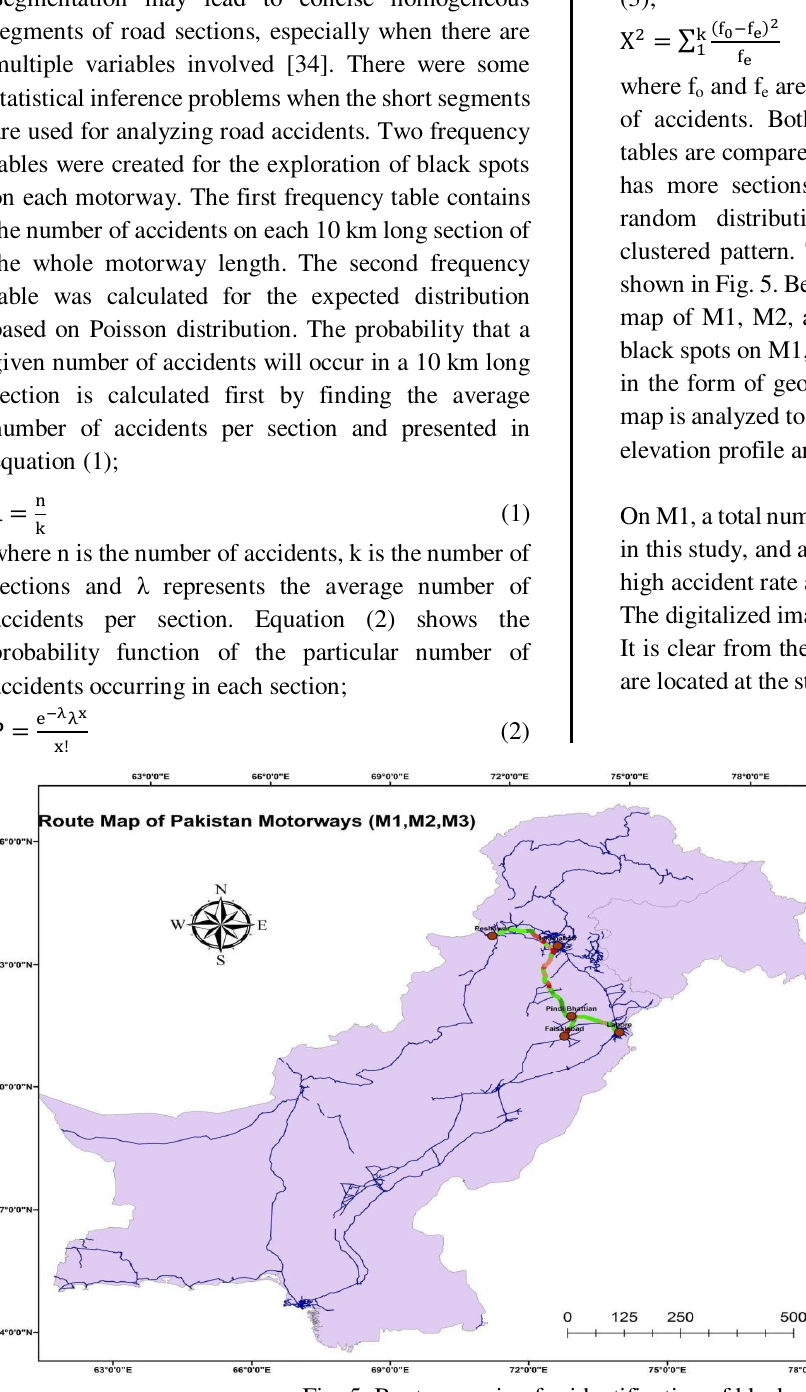
Fig. 5: Route mapping for identification of black